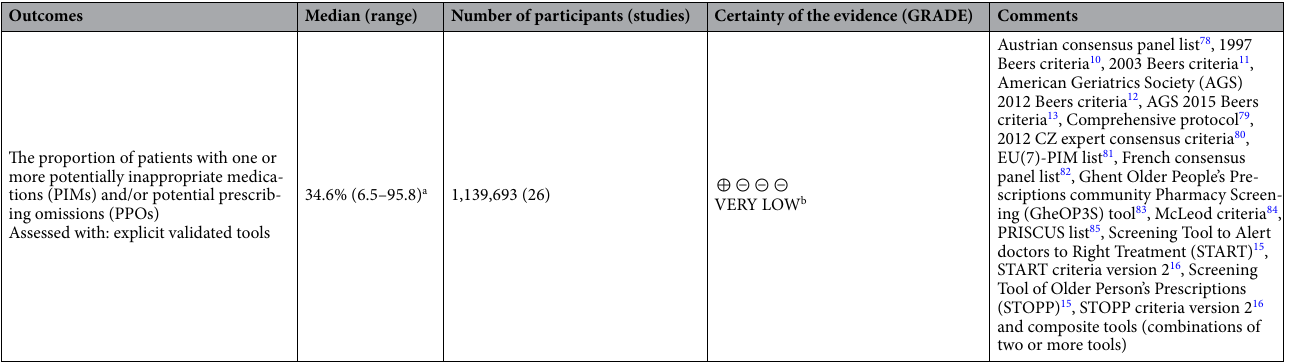
Table 3. Summary of findings. GRADE Working Group grades of evidence: High quality – we are very confident that the true effect lies close to that of the estimate of the effect; Moderate quality – we are moderately confident in the effect estimate: the true effect is likely to be close to the estimate of the effect, but there is a possibility that it is substantially different; Low quality – our confidence in the effect estimate is limited: the true effect may be substantially different from the estimate of the effect; Very low quality – we have very little confidence in the effect estimate: the true effect is likely to be substantially different from the estimate of effect. a One study by Kosinska et al. 61 and part of the results from one study by Popovic et al. 68 were excluded from the analysis because a unit of analysis was prescription, not a patient. b We downgraded the evidence three levels from high to very low due to the risk of bias (most studies at high or unclear risk of bias), imprecision (number of studies with small sample sizes), and inconsistency (considerable heterogeneity).